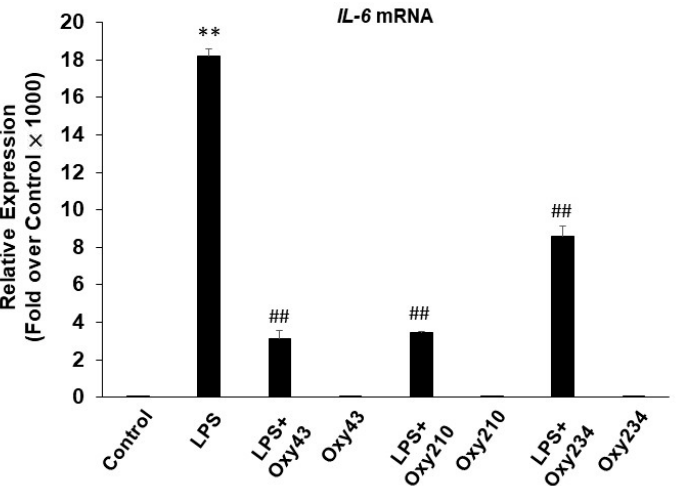
Figure 6. Inhibition of LPS-induced inflammatory gene expression in RAW264.7 macrophages by oxysterols. RAW264.7 cells were pretreated with the oxysterols (5 µ M) as indicated in DMEM containing 0.1% FBS for 24 h followed by the addition of LPS (25 ng/mL) in the absence or presence of the oxysterols (5 µ M). After 24 h, RNA was extracted and analyzed by Q-RT-PCR for the expression of IL-6 and normalized to Oaz1 expression. Data from a representative experiment are reported as the mean of triplicate determinations ± SD (** p < 0.01 vs. control; ## p < 0.01 vs. LPS).